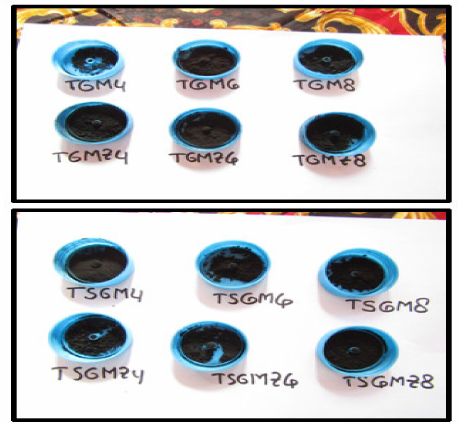
Figure 8. Products of CNS (code without Z) and ZnO/CNS nanocomposites (code with Z) which were resulted from evaporation of the colloids of the carbon prepared from sawdust (SG) and rice husk (G).